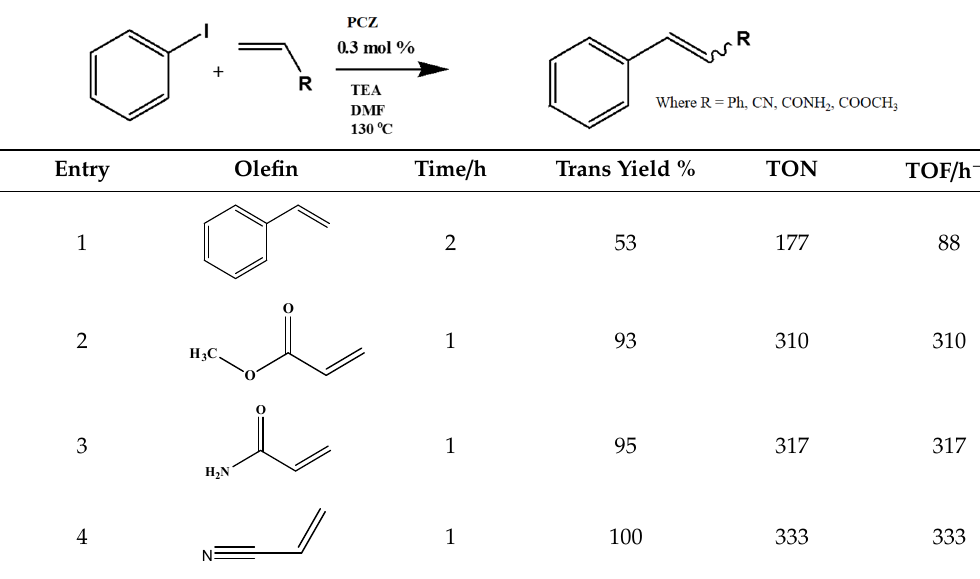
Table 7. Influence of olefin electronics on the yield and progression of reactions.